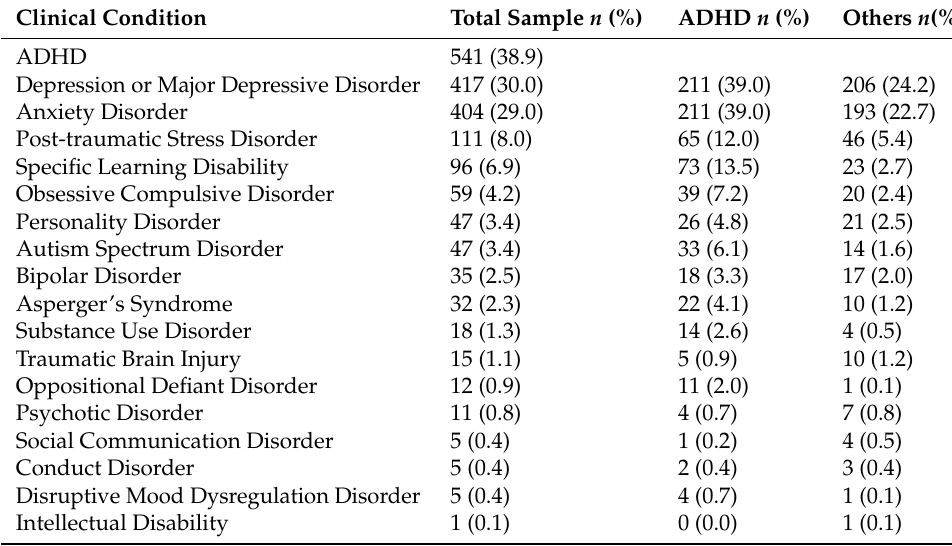
Table 1. Clinical conditions claimed from a pre-determined list ( n =